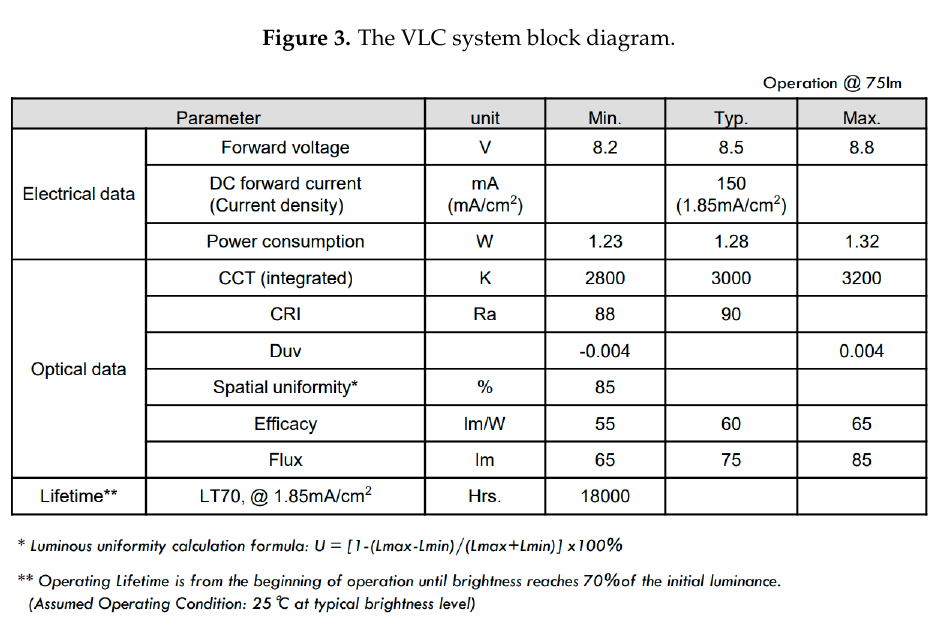
Figure 4. OLED electrical and optical characterictics [38].